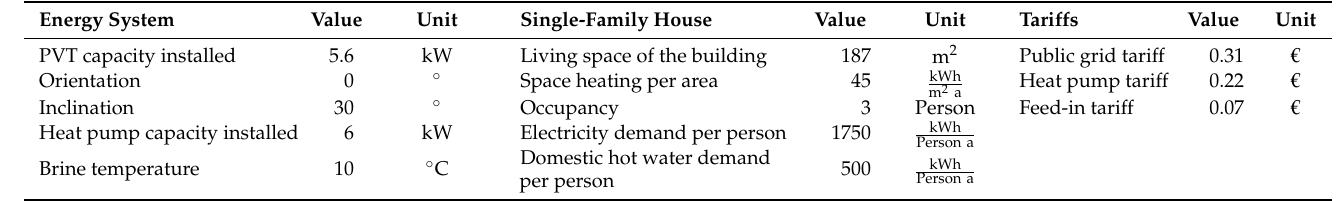
Table 1. Assumptions for the modeled energy system, for the single-family house (SFH), and electricity tariffs.